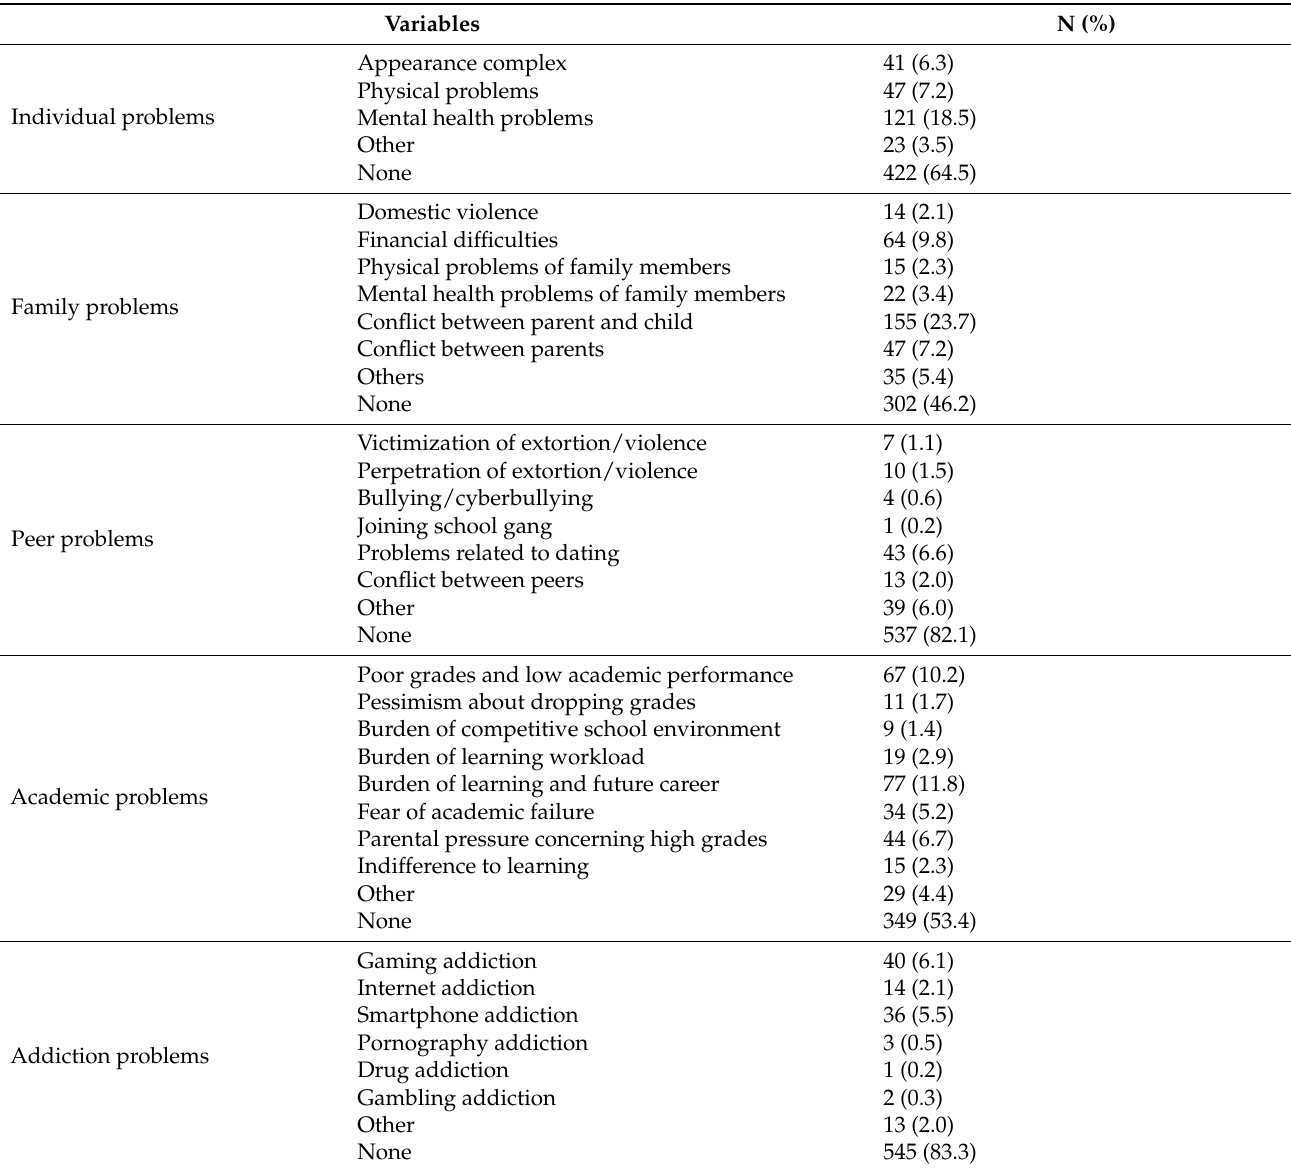
Table 2. Usual concerns revealed at school within one year prior to the death of a student who died by suicide in 2016–2020 (N =